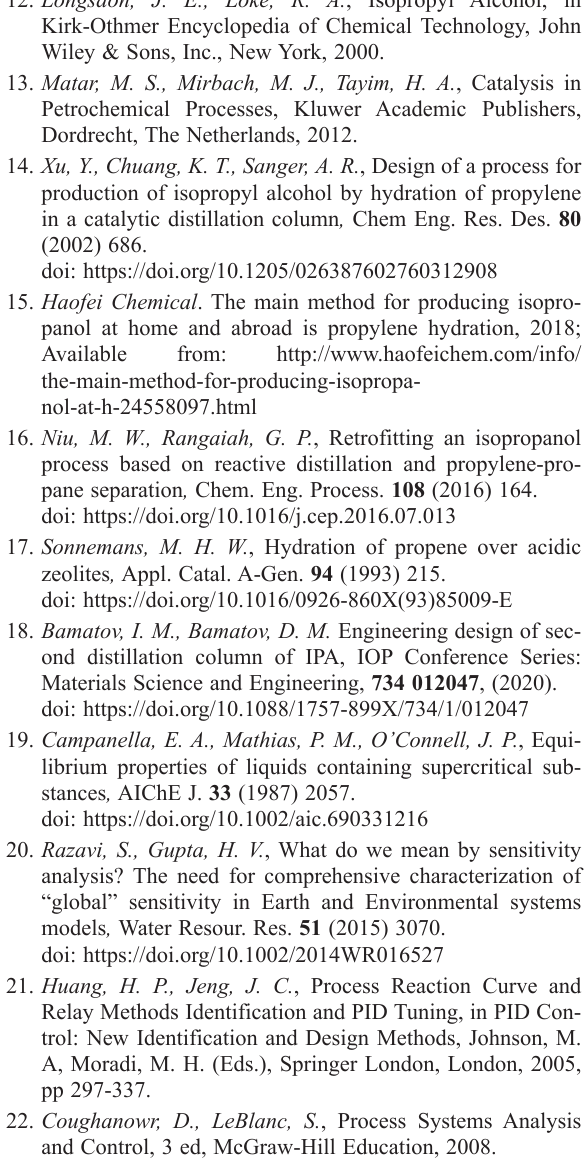
R e f e r e n c e